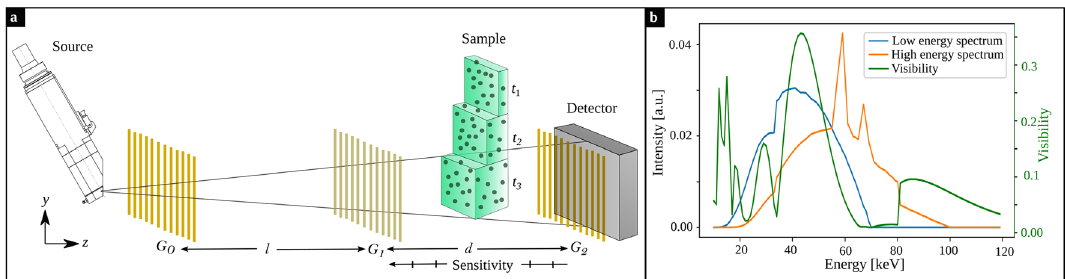
Figure 1. Experimental setup, source spectra and visibility spectrum. ( a ) The Talbot-Lau interferometer consists of three gratings. The sample is a step phantom consisting of different thicknesses of the material of interest. The sensitivity increases towards G 1 . ( b ) The simulated detected spectra (cf. Eq. 7) are plotted in blue and orange for the low and high energy bin, respectively. The simulated visibility spectrum for the given grating parameters and setup geometry is shown in